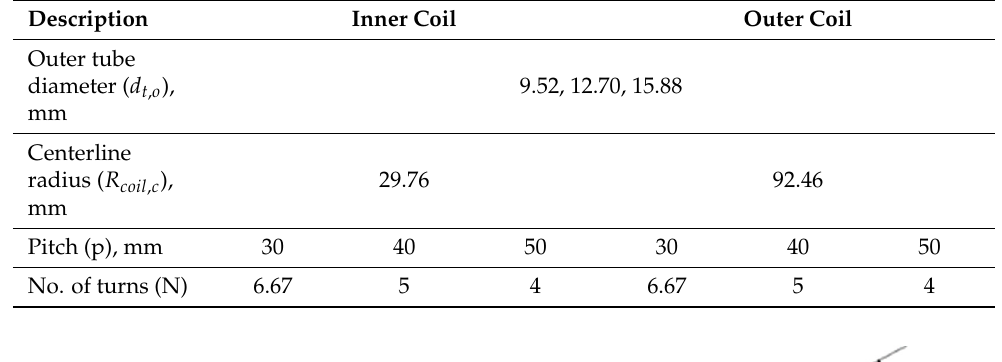
Table 3. Geometrical parameters of the twin-centric helical coils.